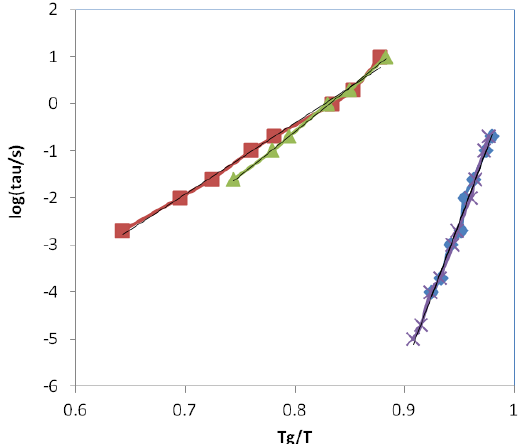
Figure 13. Fragility plot for epoxy, HBPEI and ELP samples: epoxy at 2 K/min, rhombus; HBPEI at 2 K/min, squares; HBPEI at 0.5 K/min, triangles; ELP at 0.5 K/min, crosses.